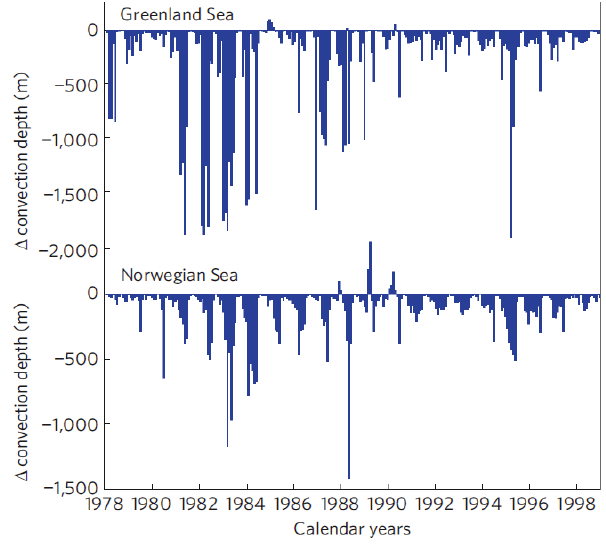
Figure 6. Differences in the monthly maximum depth of open- ocean convection in ocean model experiments with and without po- lar lows included in the atmospheric forcing (a) the Greenland Sea and (b) the Norwegian Sea. Reproduced with permission from Con- dron and Renfrew